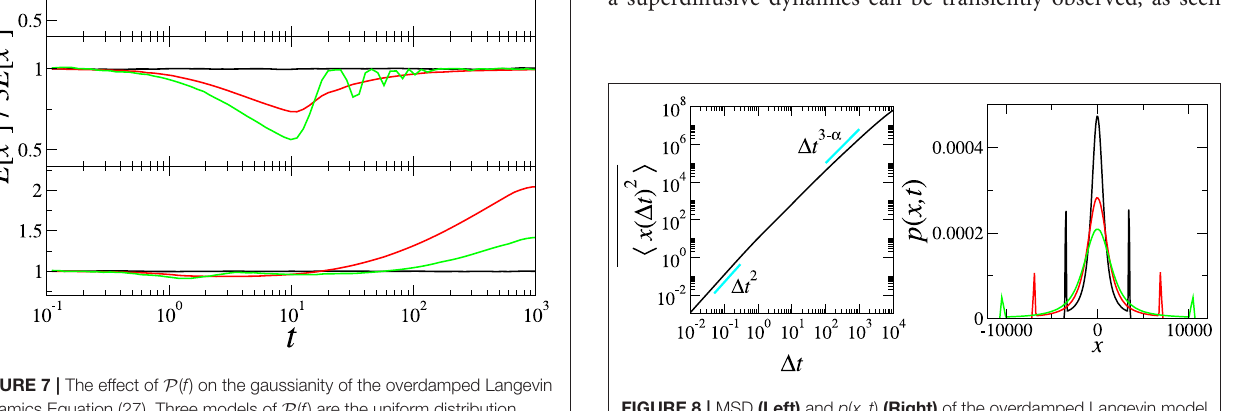
exp ( f 2 / 2) / √ 2 π = − 1 1 δ ( f δ ( f 1) 1) (green). From Top to 2 2 = + + −